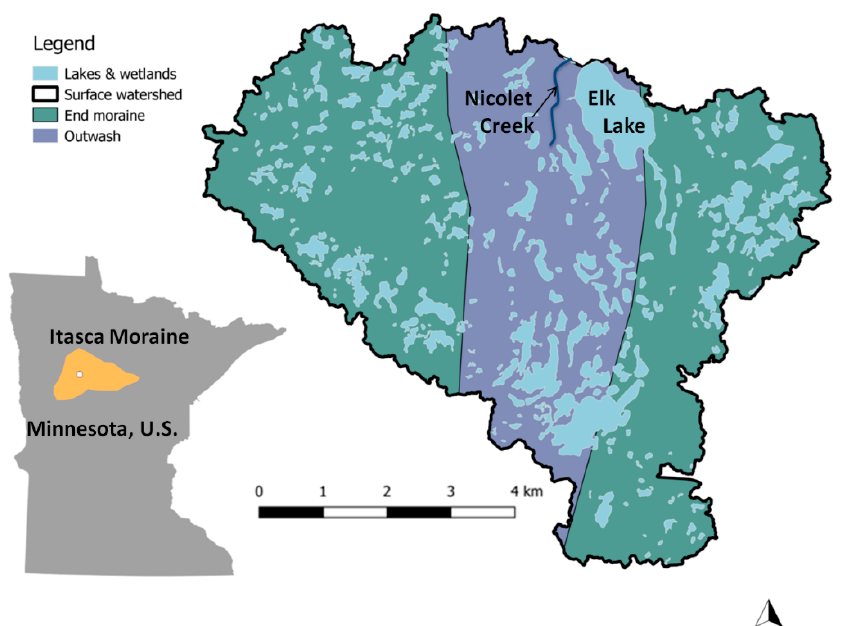
Figure 2. Insert (lower left) shows Minnesota, U.S., and the Itasca Moraine (orange). The map on the right shows the Elk Lake and Nicolet Creek (topographic/surface watershed outlined in black). Surficial Quaternary geology map of the study area is from Hobbs and Goebel (1982) overlain with lake and wetland areas (light blue), which were used to interpolate the water-table surface.